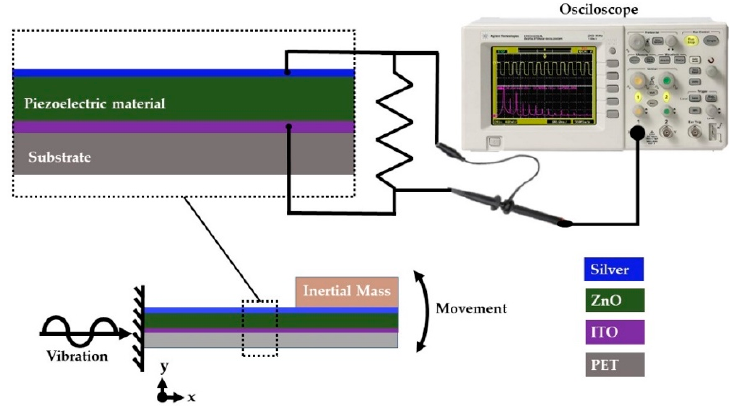
Figure 7. Schematic view of the short circuit (Vsc) characterization system of the flexible pVEH microdevice.